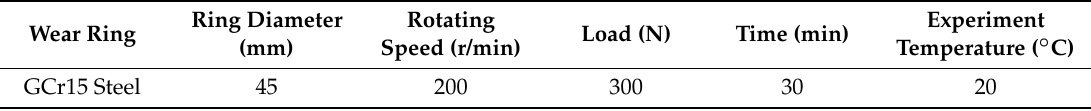
Table 1. Experimental parameters of the wear